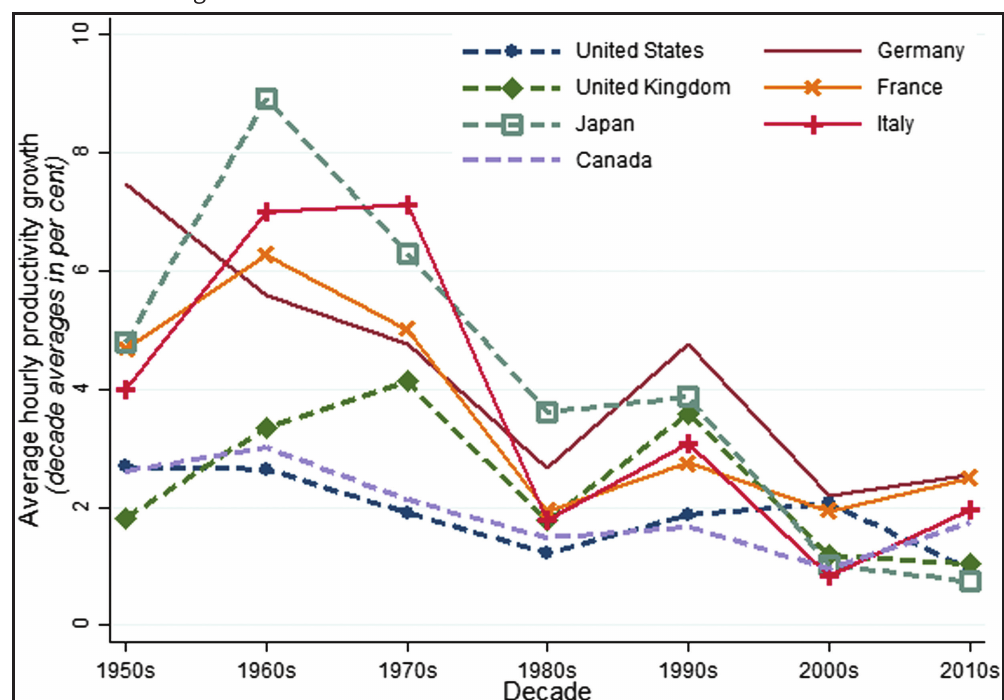
Figure 2 Hourly productivity growth rates in Group of Seven (G7) countries, decade